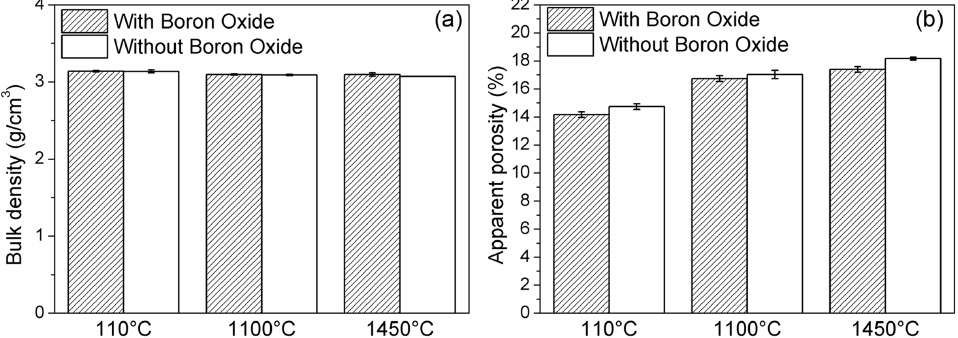
Figure 1: Bulk density (a) and apparent porosity (b) of castables after heat treatment at 110, 1100 and